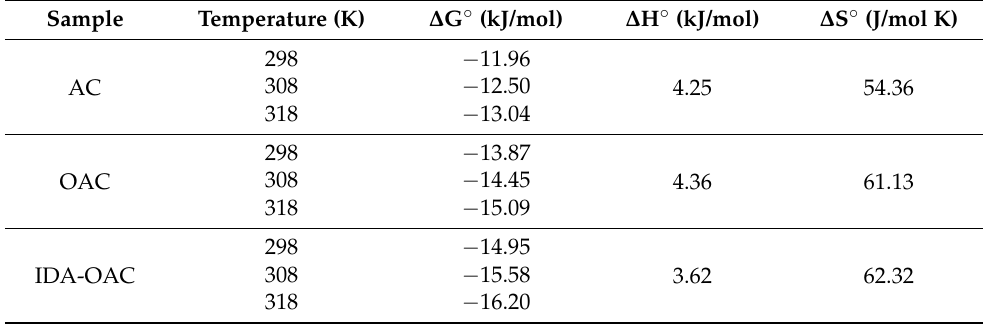
Table 6. Thermodynamic parameters for the AC, OAC, and IDA-OAC.